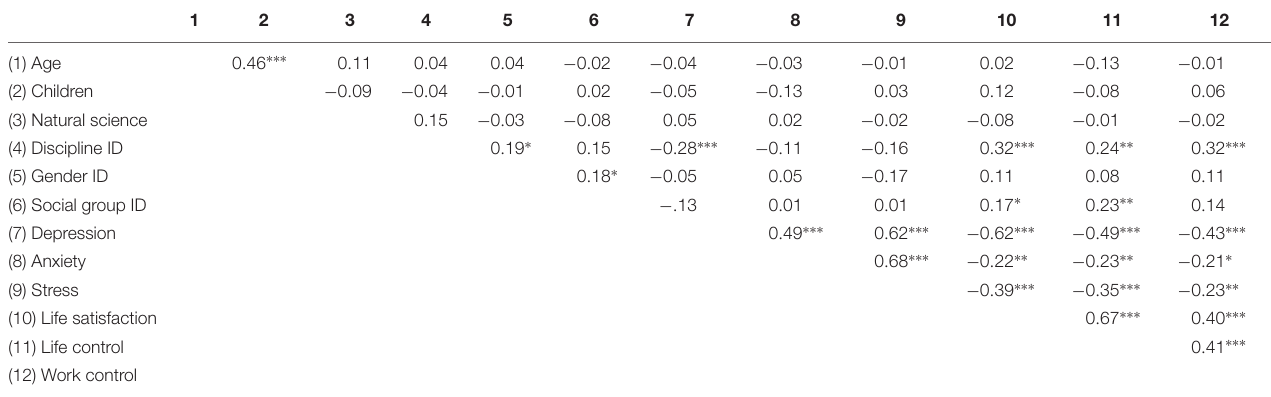
TABLE 3 | Bivariate correlations among variables in Study